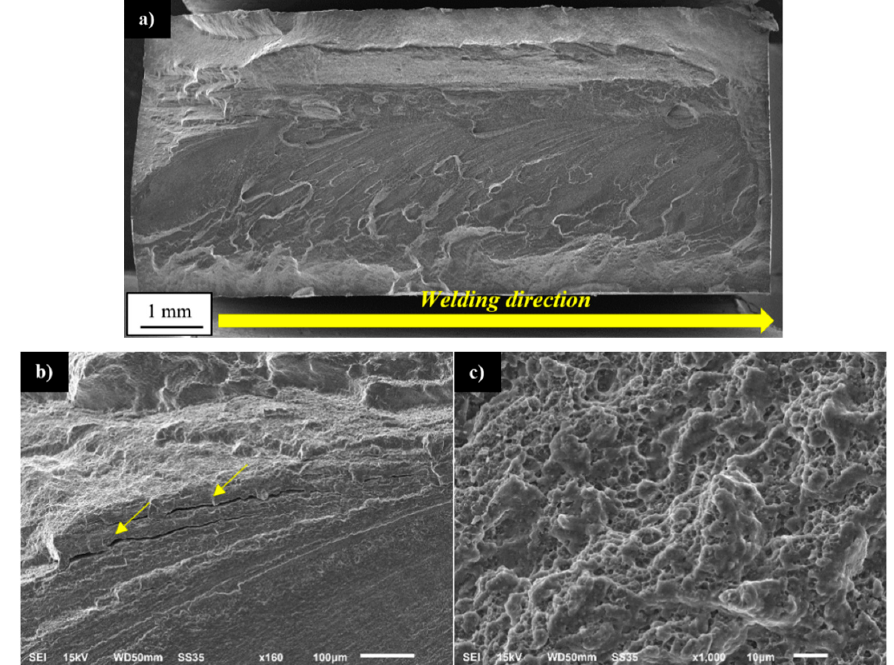
Figure 18. SEM images of fatigue surfaces of a specimen tested at a strain amplitude of 0.8%: ( a ) overall view of the fracture surface, ( b ) upper part of the SZ surface, and ( c ) magnified view of the SZ surface. The yellow arrows indicate the secondary cracks.